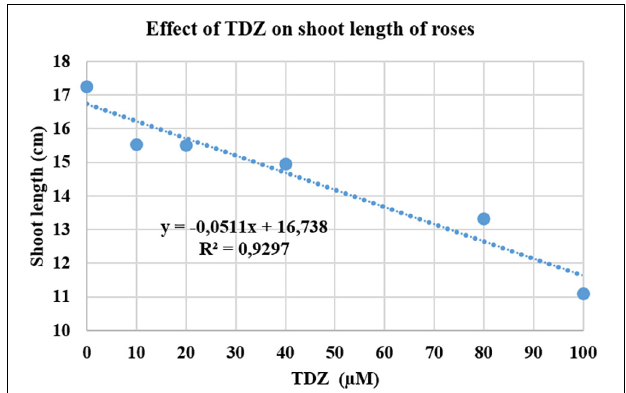
FIGURE 1 | Effects of thidiazuron (TDZ) concentrations on the length of the primary shoot in miniature rose plants. Potted plants were sprayed with different concentrations of TDZ and then placed in the greenhouse for 2